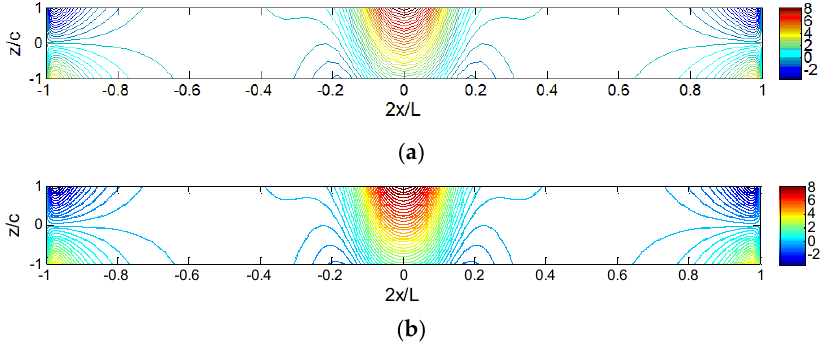
Figure 6. Comparisons of iso-stress ( σ zz / q ) diagram for sandwich panels under locally distributed loads ( L p = 0.1 L ): ( a ) HDQM; and ( b ) ABAQUS.